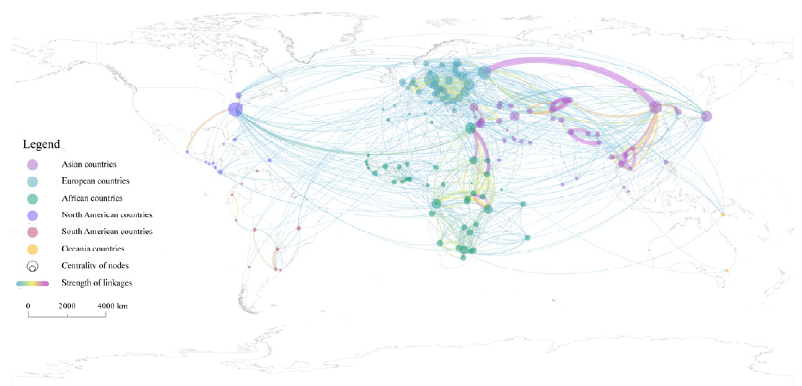
Figure 5. Spatial pattern of transboundary water cooperation linkages based on intensity weighting.